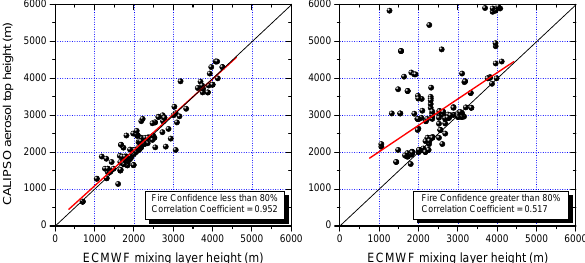
Fig. 5. Comparison of aerosol top height derived by CALIPSO with mixing layer height from ECMWF model for fire confidence less than 80% (left panel) and greater than 80% (right panel).